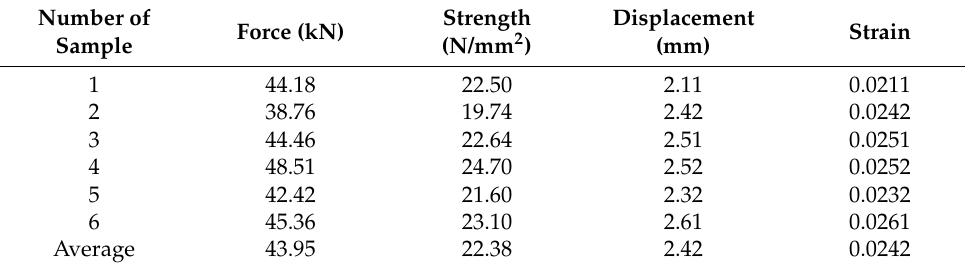
Table 2. Compressive strength for 7 days of curing.